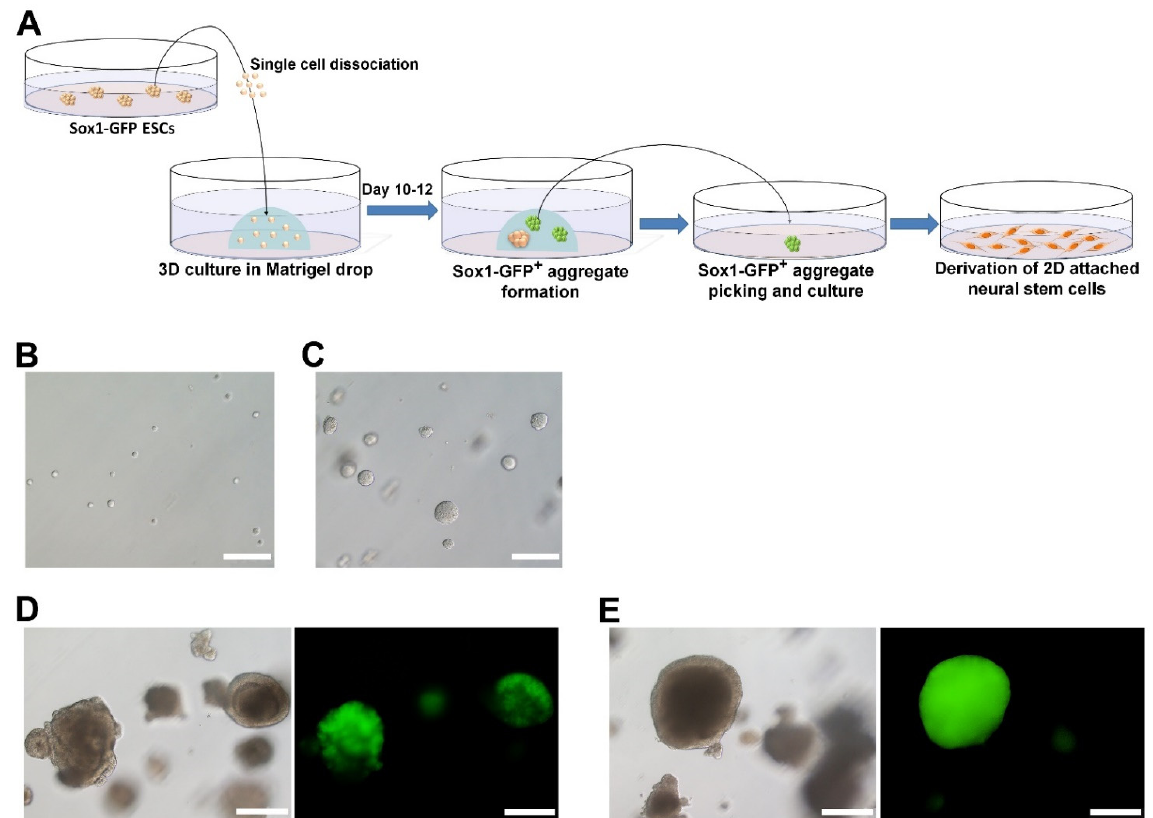
Figure 1. Differentiation of Sox1 -GFP ESCs into neural stem cells (NSC). ( A ) Schematic illustration of the NSC induction protocol. ( B ) Dissociated single cells of Sox1 -GFP ESCs embedded in Matrigel drops. ( C ) Aggregate formation of Sox1 -GFP ESCs in Matrigel on day three. ( D ) Sox1 -GFP-expressing cells appeared on day seven after culture in the Matrigel drop. ( E ) On day 10, Sox1 -GFP-expressing aggregates were picked and used for NSC derivation. Scale bars = 200 μ m.